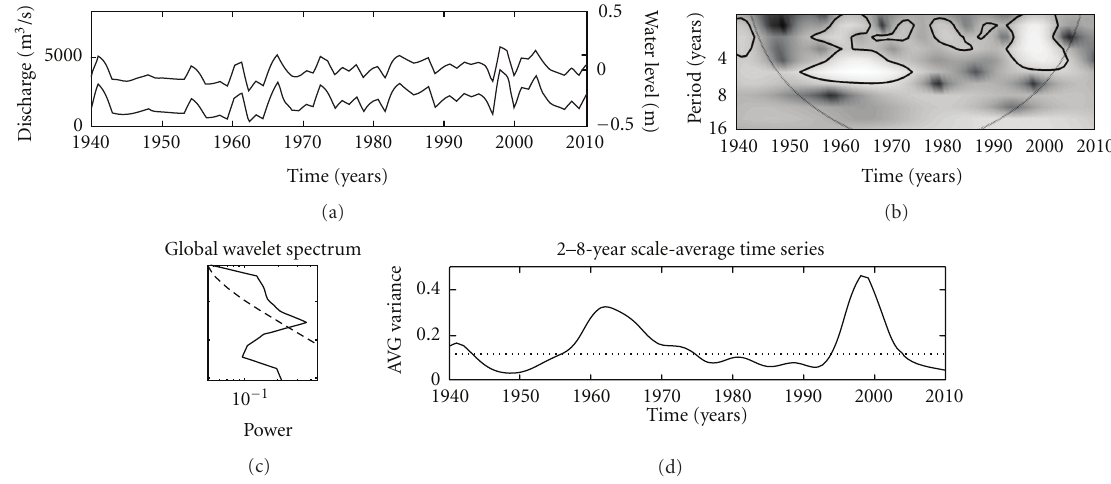
Figure 9: Freshwater discharge and water level in Rio Grande (a), cross-wavelet between freshwater and water level in Rio Grande (b), global wavelet spectrum (c), and average variance between 2 and 8 years